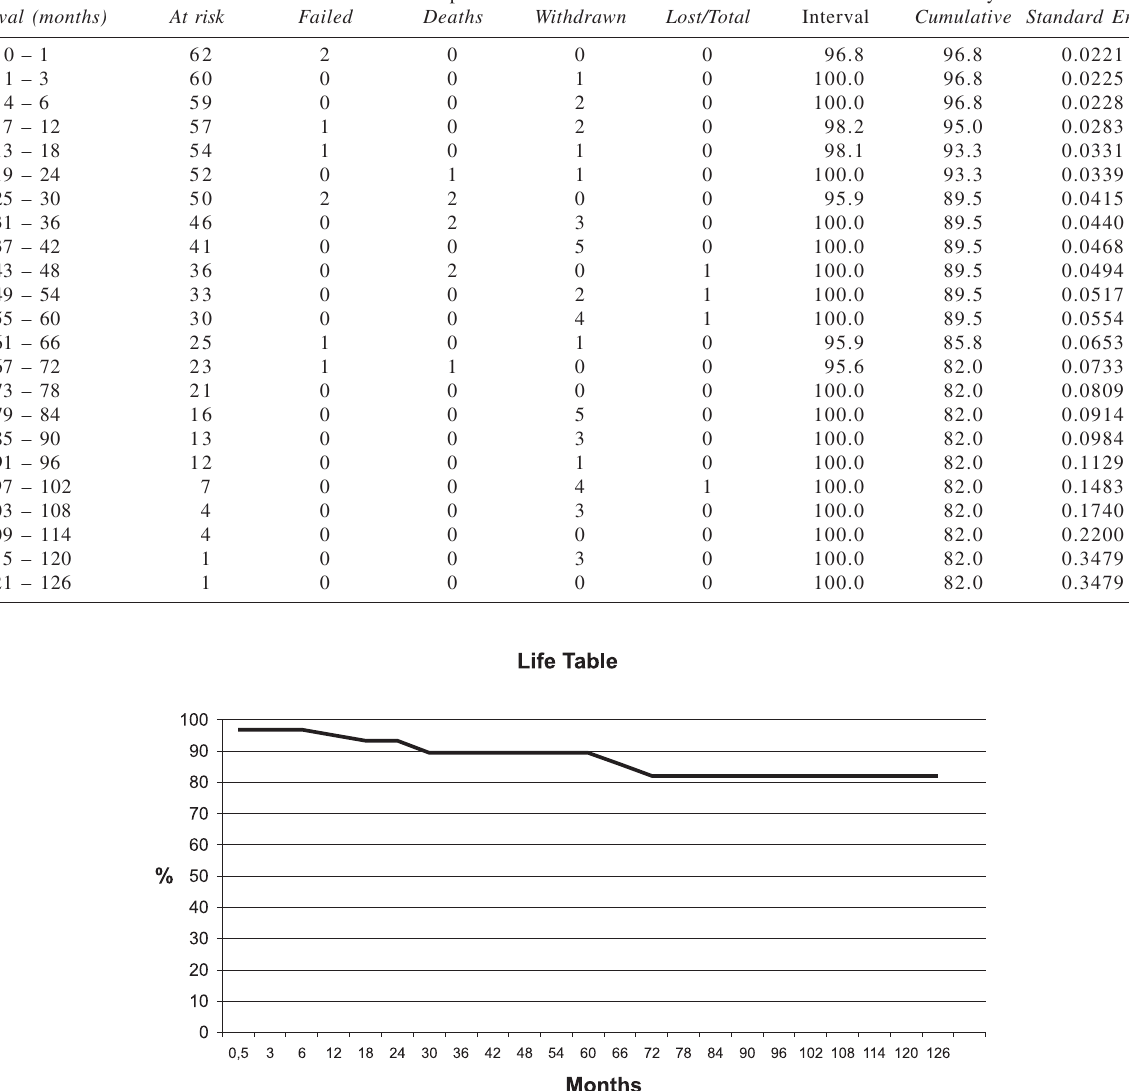
Table 2 - Long-term cumulative primary patency of endovascular procedures No of patients